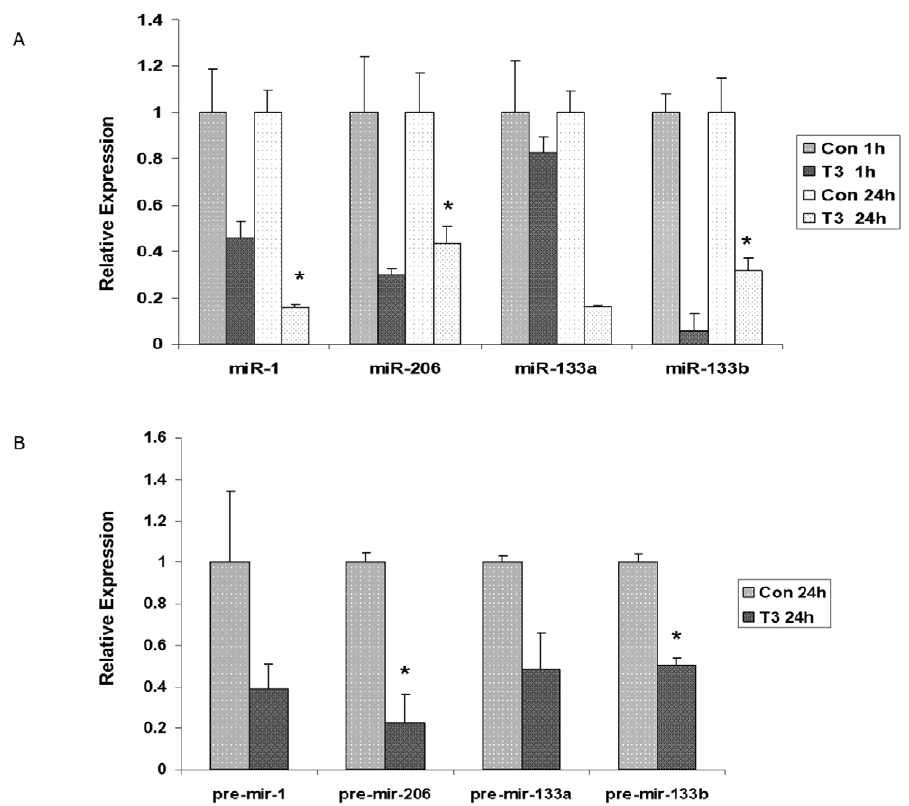
Figure 3. Expression of miRs-1, 206, 133a and 133b as well as their precursors in the AML 12 cells. A. AML 12 cells were treated with 10 nm T3 for 1 hour or 24 hours. The expression of miRs-1, 206, 133a and 133b was examined with the Taqman miRNA Assay. U6 was used as an internal control. Five batches of cultured cells were considered as 5 biological replicates. B. The expression of the precursors of miRs-1, 206, 133a and 133b was examined in AML 12 cell treated with 10 nm T3 for 24 hours with RT-PCR. Hprt was used as internal control. Three batches of cultured cells were used as 3 biological replicates. Data are presented as mean 6 SE. A two-tailed Student’s t-test was used to calculate significance. * indicates p , 0.05.